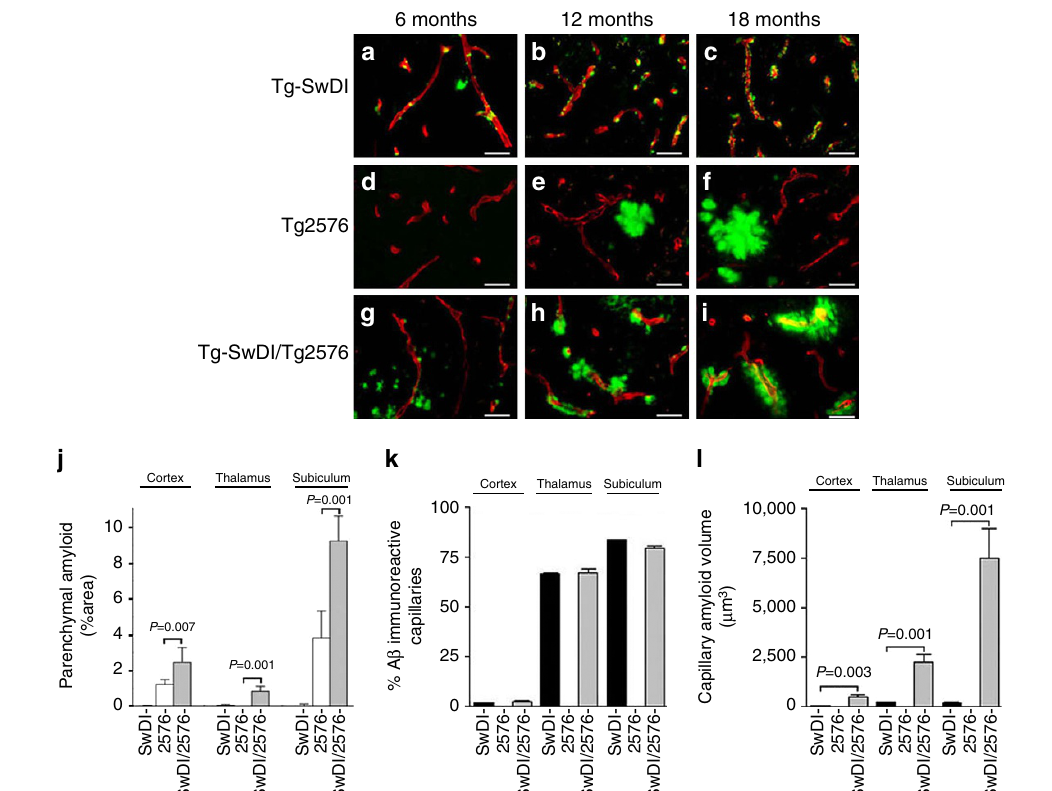
Figure 4 | Increased cerebral capillary amyloid deposition in bigenic Tg-SwDI/Tg2576 mouse brain. Transgenic mouse brain sections (from 6 to 18 months old) were stained for fibrillar amyloid using thioflavin S (green) and immunolabelled for cerebral blood vessels using an antibody to collagen IV (red). ( a – c ) Tg-SwDI mice; ( d – f ) Tg2576 mice; and ( g – i ) bigenic Tg-SwDI/Tg2576 mice. Scale bar, 25 m m. Transgenic mouse brain sections (from 18 months old) were stained for fibrillar amyloid using thioflavin S and immunolabelled for cerebral blood vessels using an antibody to collagen IV. ( j ) The area occupied by parenchymal fibrillar amyloid plaques was determined in specific brain regions of each transgenic mouse line using